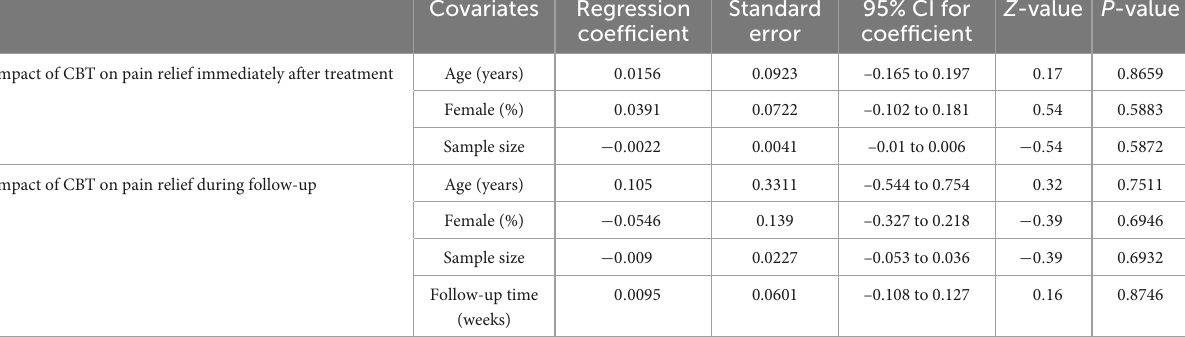
TABLE 2 Meta-regression for